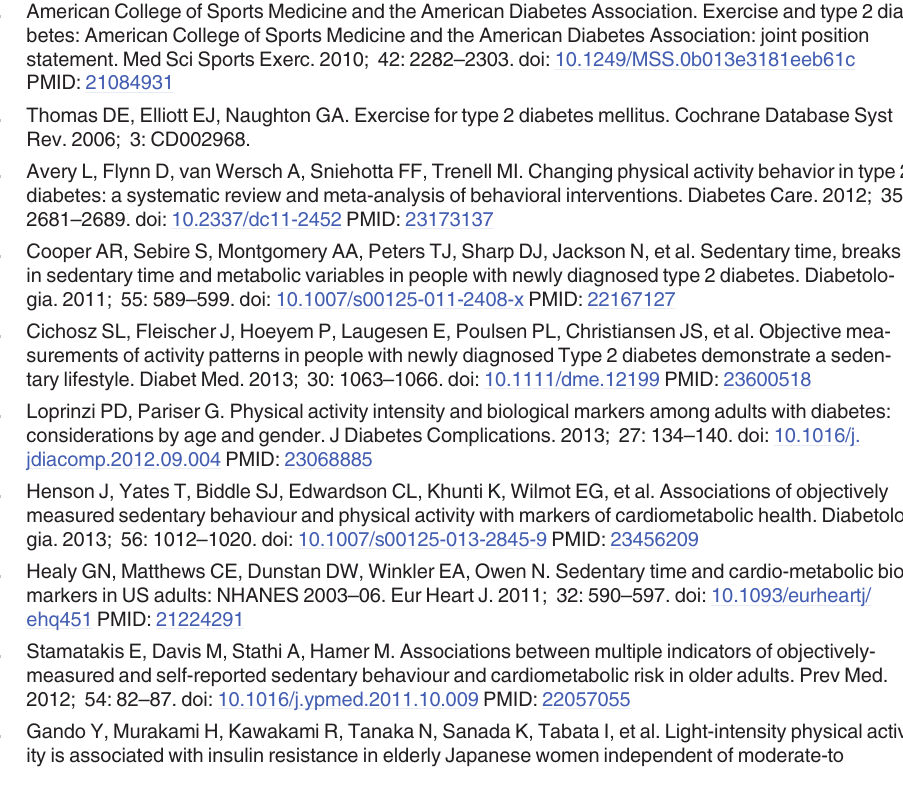
S2 Table. Associations of activities a (Model 2) with continuous cardio-metabolic biomark- ers, adjusted for all other activities and potential confounders, in n = 279 adults with type 2 diabetes and an overweight/obese BMI